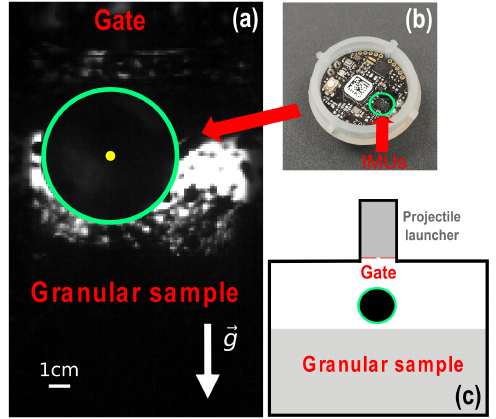
Figure 1. (a) Side-view of a projectile moving towards the gran- ular sample under microgravity. g denotes the direction of grav- ity. The yellow dot and green circle represent the position and circumference of the projectile obtained with Hough transforma- tion, respectively. (b) Snapshot of the lower half of the projectile with sensor circuit board embedded. Note that the IMU sensor is o ff -center. (c) Cross-section of the cylindrical experimental set-up mounted in the drop tower capsule.